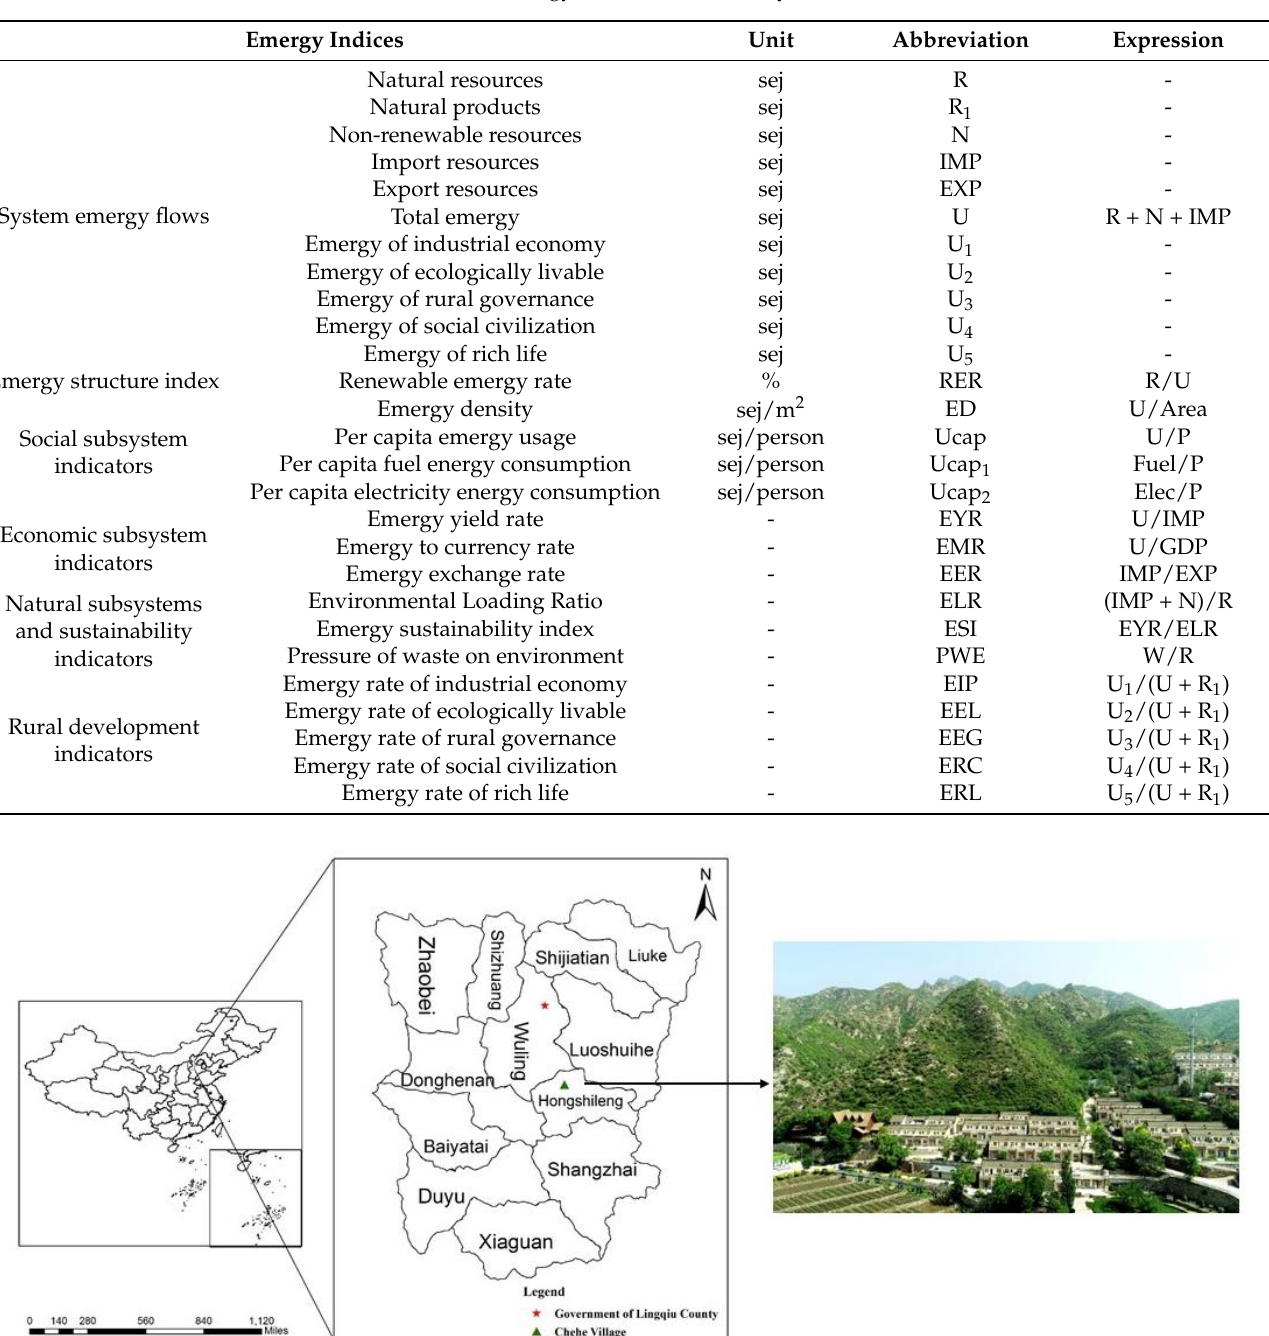
Figure 3. Flowchart of Chehe Village operation mode. Note: the flowchart was drew by author ac- cording to survey and interview. 2.3. Data Collection The climate information involving sunlight, precipitation, wind speed, and average altitude were obtained from Bureau Meteorology and Lingqiu County statistical yearbook. Raw data of diesel and waste were referred to China statistical yearbook, Ministry of In- dustry and Information Technology of the People’s Republic of China, Wang et al. (2004) [44]. Furthermore, we extracted some information from the local government report, re- lated documents and website, and relevant personal interviews. Moreover, most raw data of different flows including renewable resources, non-re- newable resources, import products and services, export products and services were ac- quired through questionnaire survey of village head or farmers in a field investigation activity for one week in August 2020 to insure the specificity and validity of the data. Finally, we revised the questionnaire according to the local conditions and get the validity data to analyze the results. There were three people who contributed to this paper partic- ipating in the field investigation for 30 farmers randomly and collected 30 valid question- naires. The village head had worked since 1997 and was awarded as “National Advanced